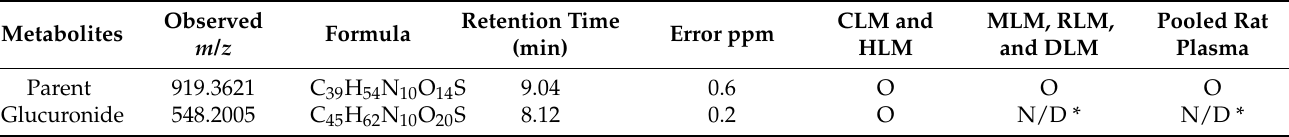
* N/D: Not detected. Figure 8. Metabolic pathways of α‐ amanitin under in vitro MetID (CLM and HLM). The total ion chromatogram (TIC) of parents and a proposed glucuronide metabolite of α -amanitin is shown in Figure 9.